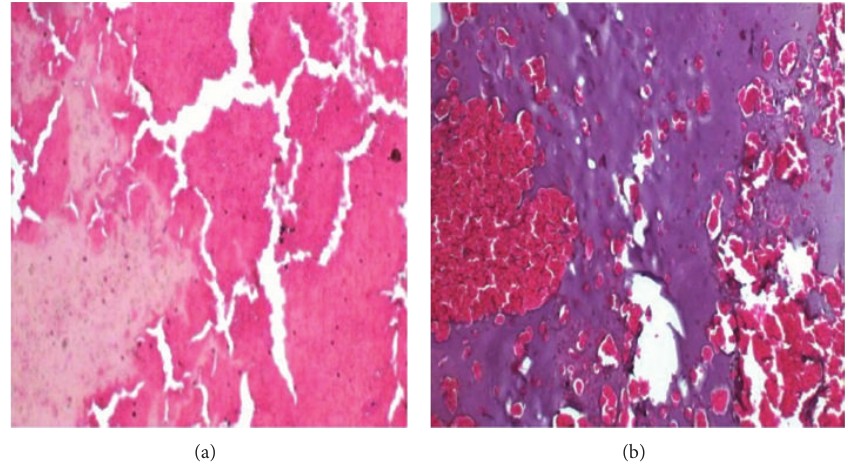
Figure 2: Images (10x) of panels (a) and (b) are taken from slides prepared from two bloods (a) normal, (b) HIGM, the red sections are the red blood cells, and the purple sections are the HIGM.